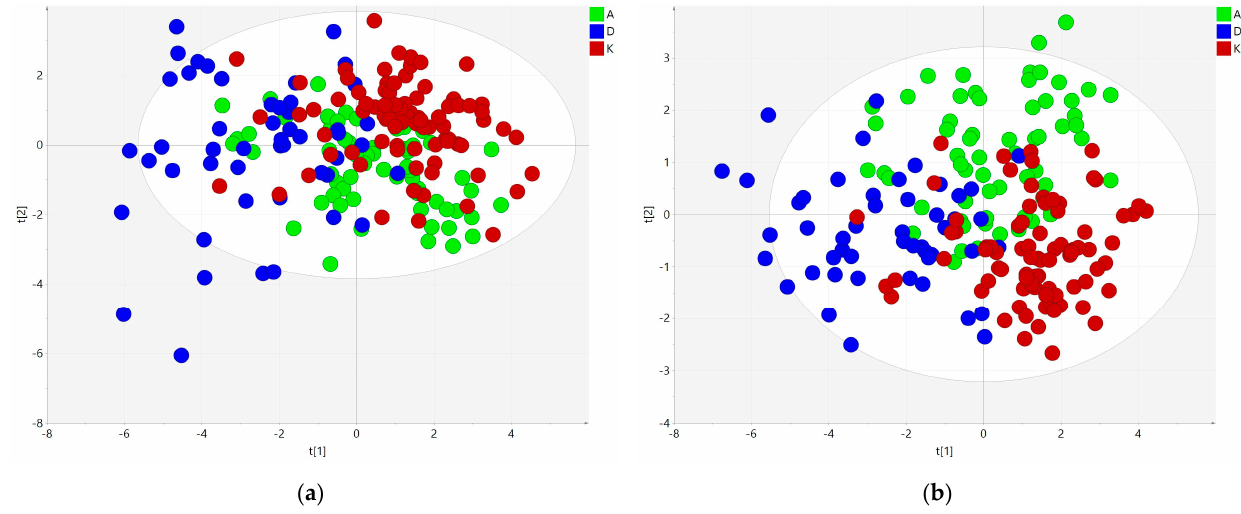
Figure 2. Explorative analysis on polar lipids subset. ( a ) PCA score plot showing clusters for all three groups ( b ) PLS-DA score plot. In this analysis of the PL subset, we noticed changes in lipids not attributable to LPL; 28 lipids exceeded a VIP score > 1. The most pronounced differences seemed to be between